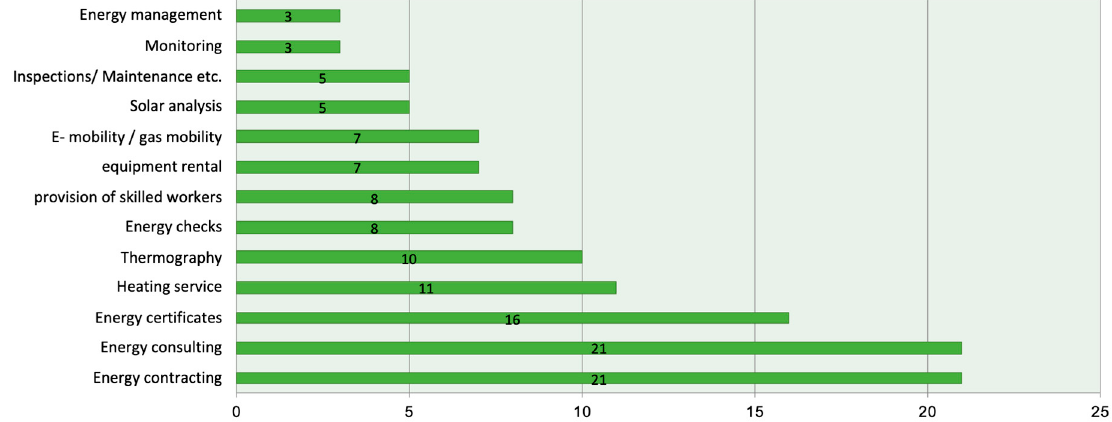
Figure 5. Services offered by energy companies (own illustration based on Berlo et al. [47]).